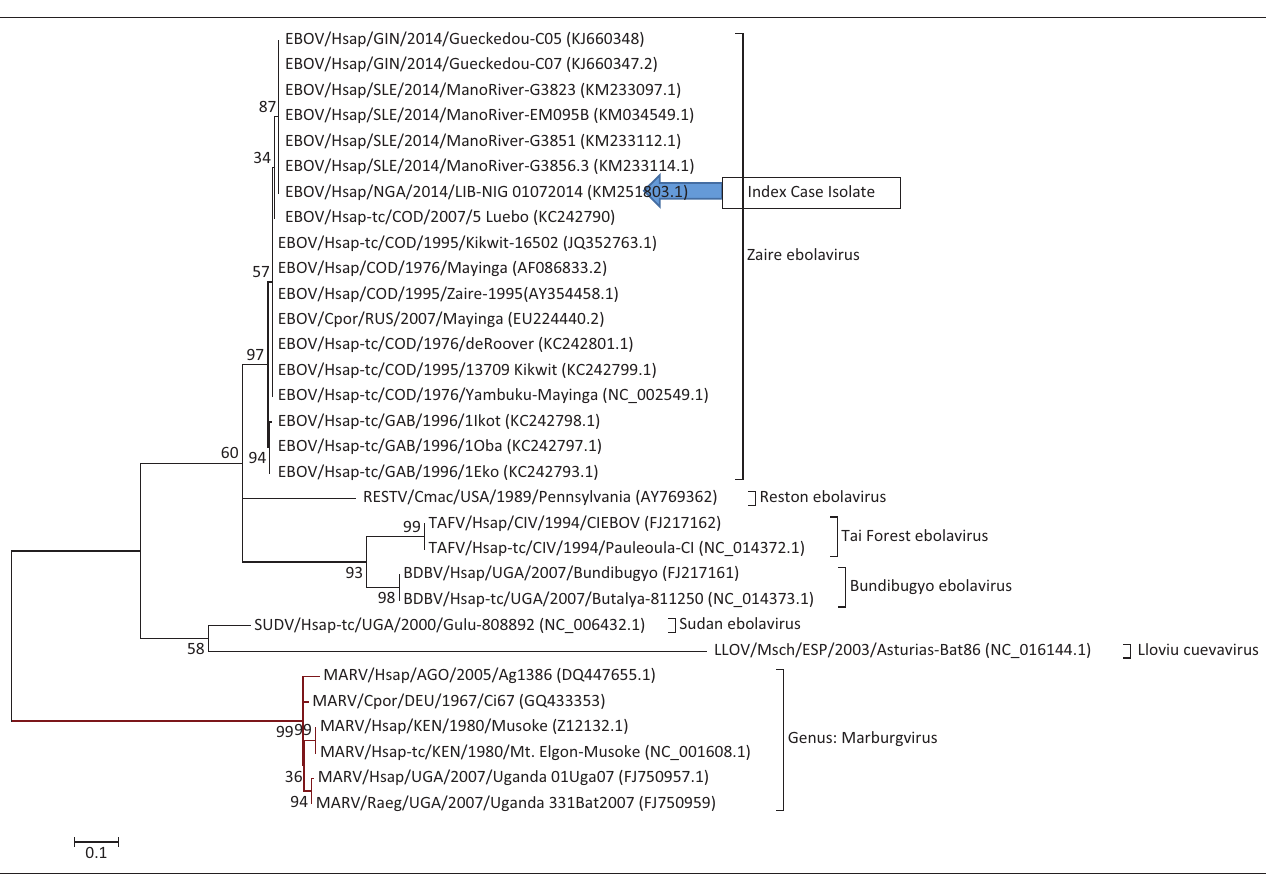
FIGURE 3: Molecular phylogenetic analysis of the L-gene segment of EBOV/Hsap/NGA/2014/LIB-NIG 01072014 in comparison with selected filoviruses sequences by the maximum likelihood method. Sequences are labelled using the ICTV consensus nomenclature for variants of the Filoviridae family with their corresponding Genebank Accession numbers in